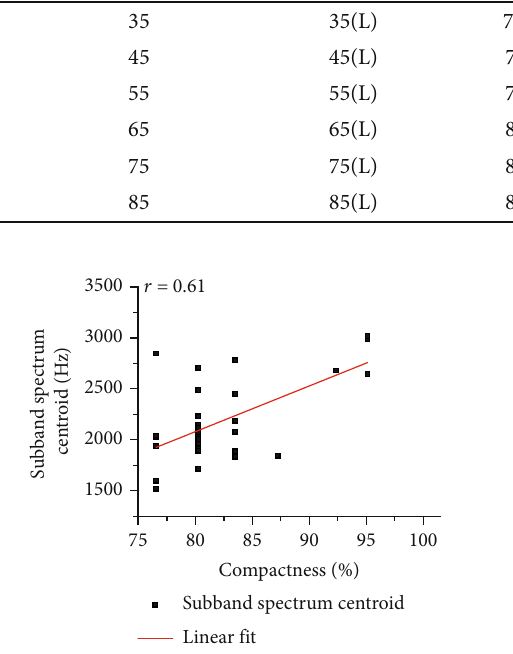
Figure 9: Correlation graphs of soil samples with di ff erent compaction degrees under the action of 35(L) N hammering force and the centroid of sound subband spectrum.